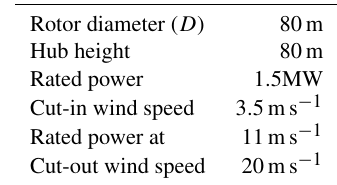
Table 1. Technical specifications of the studied wind turbines in CWEX-13 field